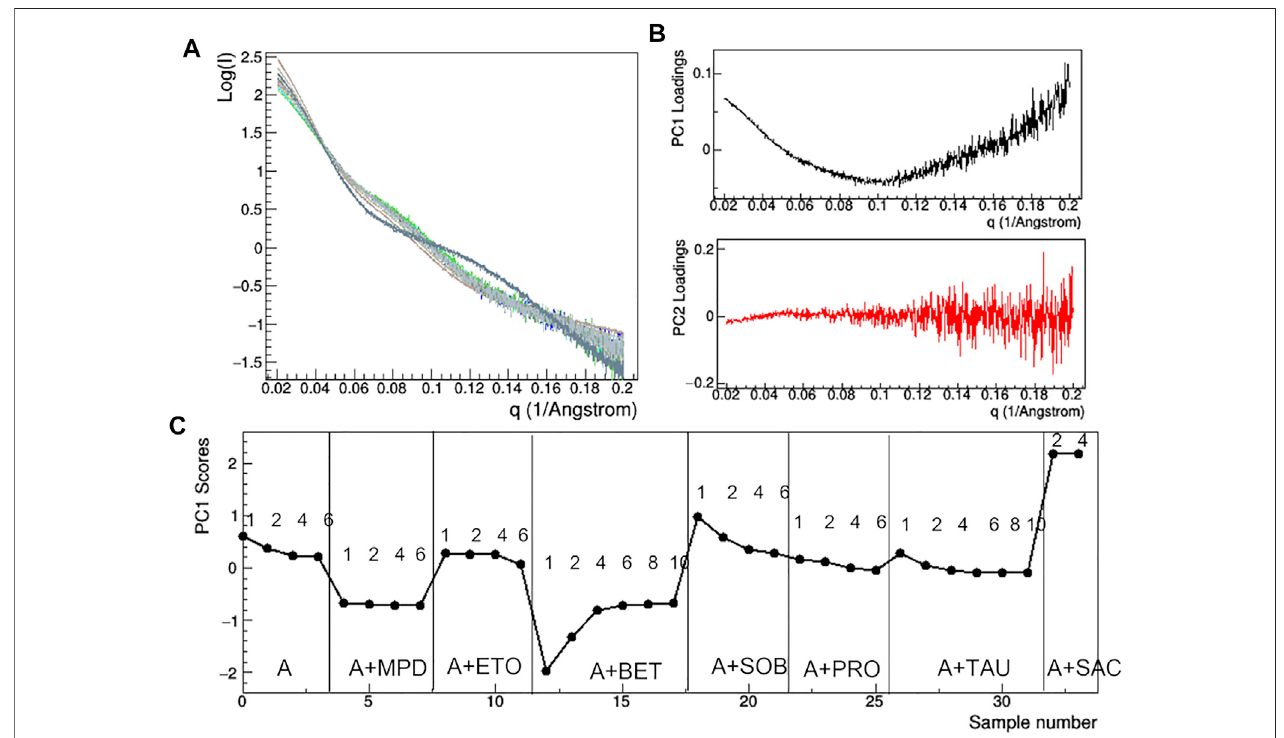
FIGURE 10 | PCA analysis of the raw SAXS data taken for rituximab in solutions containing different additives. Superposition of the individual SAXS pro fi les, representing the data matrix supplied to PCA (A) ; loadings of the fi rst (PC1) and second (PC2) principal components (B) ; PC1 scores as a function of the dataset considered,withmAbconcentrationinmg/ml andtypeofadditivereported (C) .PlotsBandChavebeenobtainedafterremovingthepro fi leofthesampleA+TWEfrom the data matrix, as it produces large deviations in the